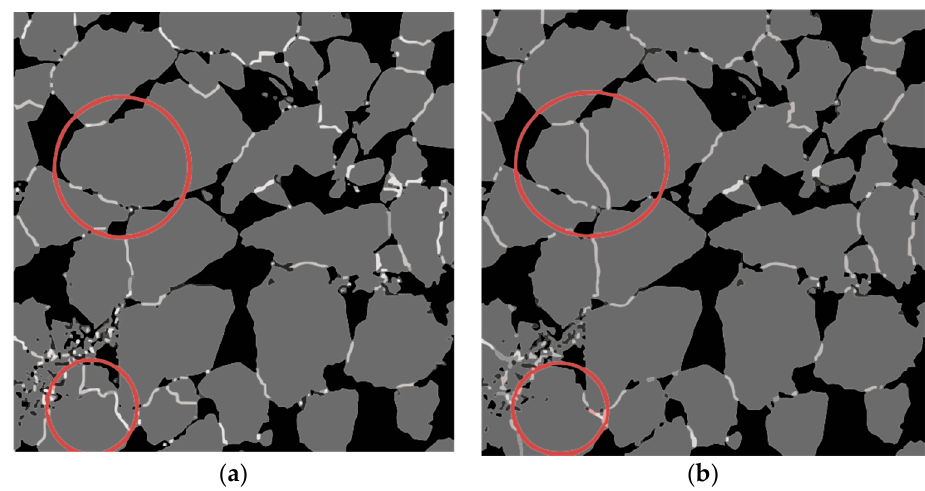
Figure 8. Micro-crack state under different pressures. ( a ) Low pressure, and ( b ) high pressure. Table 4. Orthogonal test calculation results.